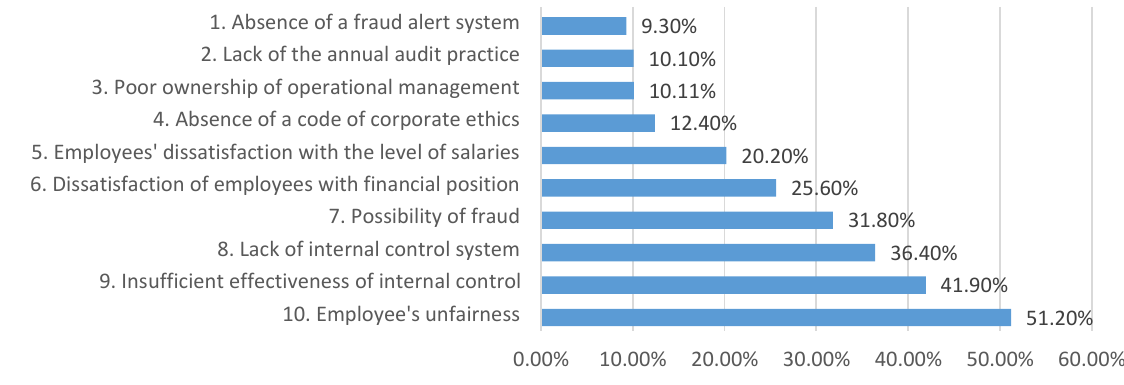
Figure 3. The factors promoting swindling at Ukrainian enterprises,